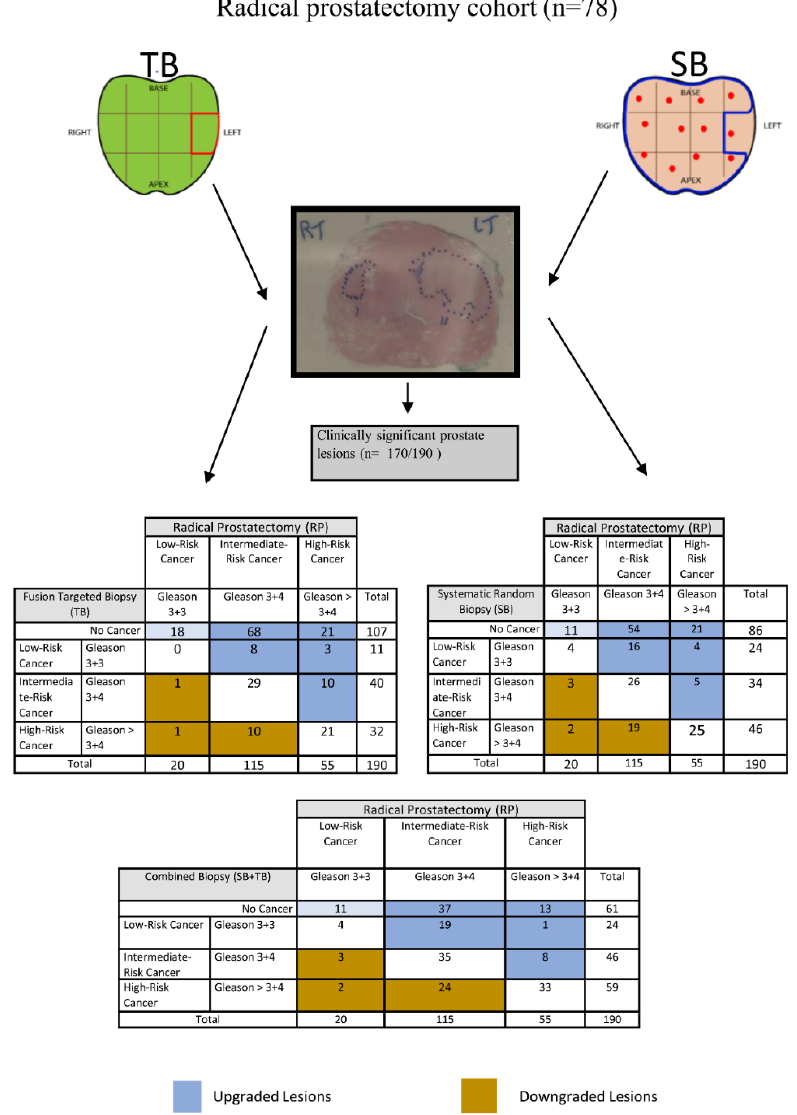
Figure 3. The detection rate of significant prostate cancer via SB, TB and combined SB+TB on RP